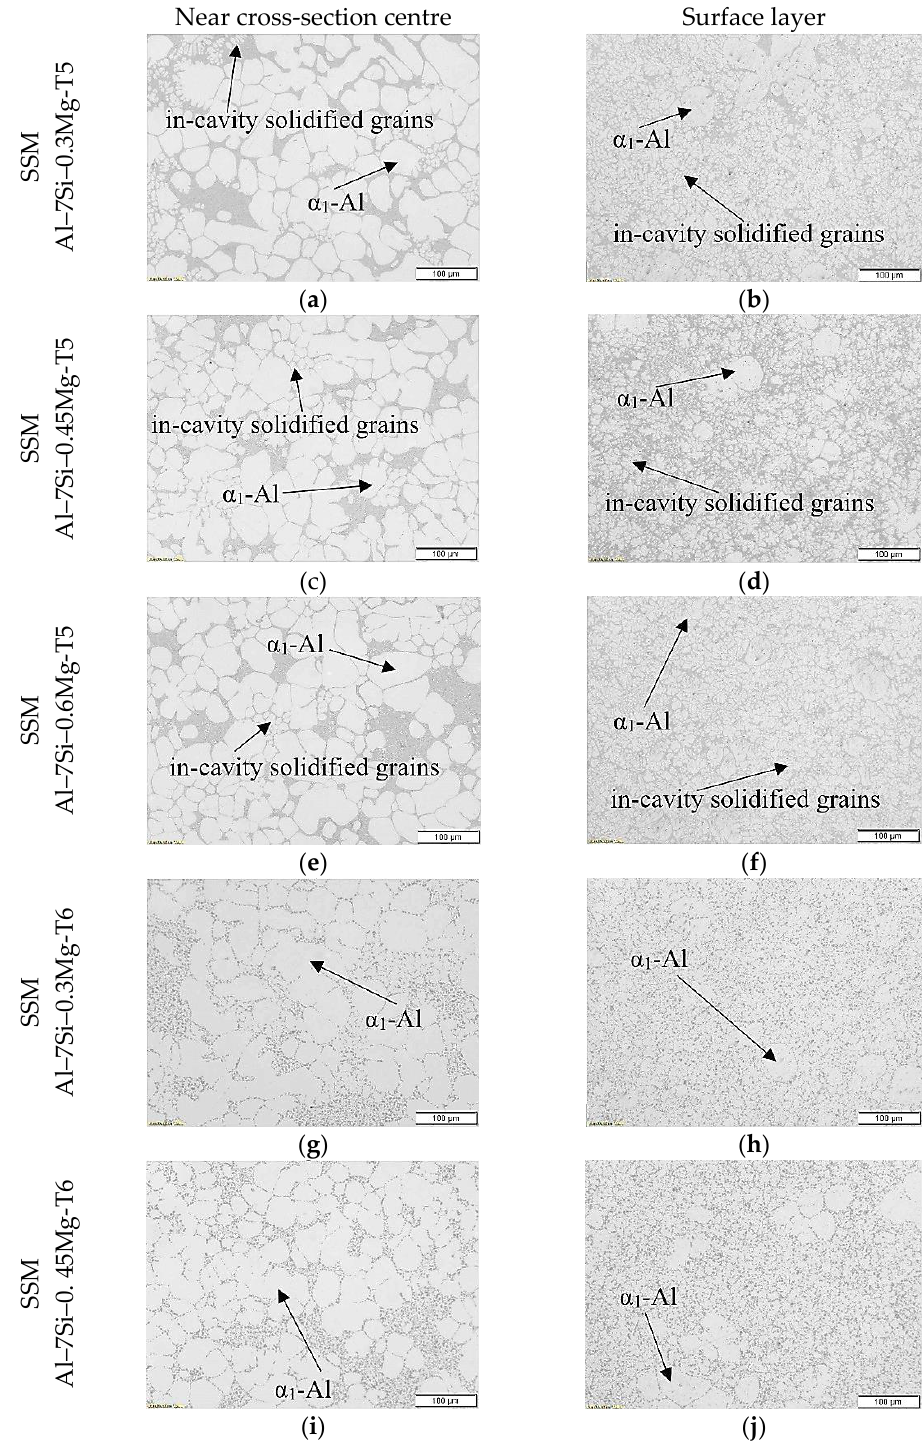
Figure 2. Optical micrographs from castings (cross-section centre and within the first 1 mm surface layer) of the different SSM Al–7Si–Mg castings, ( a ) Al–7Si–0.3Mg-T5 centre region, ( b ) Al–7Si–0.3Mg-T5 surface layer, ( c ) Al–7Si–0.45Mg-T5 centre region, ( d ) Al–7Si–0.45Mg-T5 surface layer, ( e ) Al–7Si–0.6Mg-T5 centre region, ( f ) Al–7Si–0.6Mg-T5 surface layer, ( g ) Al–7Si–0.3Mg-T6 centre region, ( h ) Al–7Si–0.3Mg-T6 surface layer, ( i ) Al–7Si–0. 45Mg-T6 centre region and ( j ) Al–7Si–0. 45Mg-T6 surface